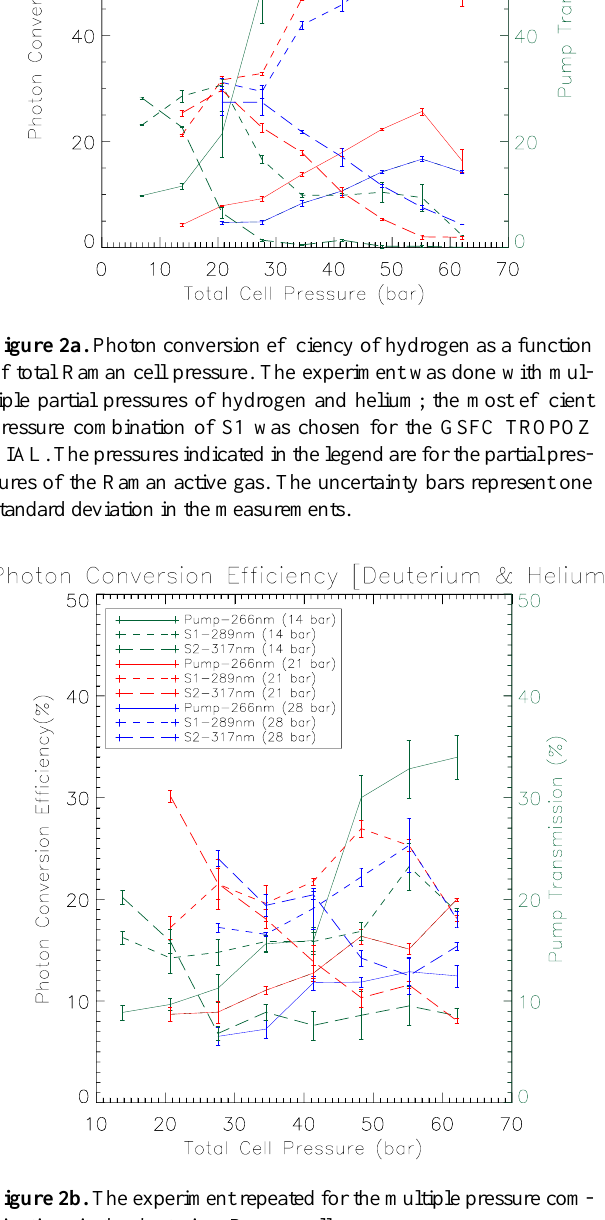
Figure 2b. The experiment repeated for the multiple pressure com- binations in the deuterium Raman